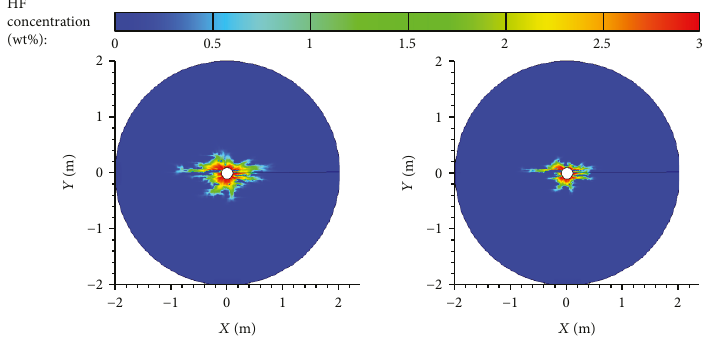
Figure 14: HF distribution in two